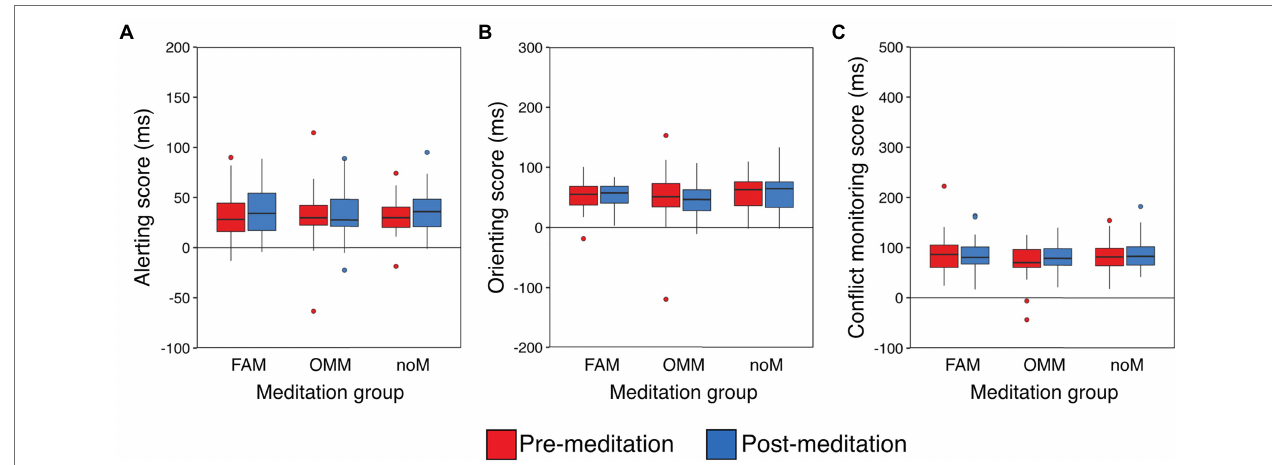
FIGURE 2 | Attentional function scores in pre- and post-meditation ANTs for the three meditation groups after excluding outliers (the scores were more than three standard deviations from the group mean), FAM: focused attention meditation, OMM: open monitoring meditation, noM: no meditation. (A) Alerting scores (FAM: n = 32, OMM: n = 30, noM: n = 32). (B) Orienting scores (FAM: n = 32, OMM: n = 31, noM: n = 31). (C) Conflict monitoring scores (FAM: n = 31, OMM: n = 31, noM: n = 31). Red and blue boxes and circles show the results of the pre- and post-meditation ANT, respectively. In each box-and-whisker plot, the central horizontal line indicates the median, and the bottom and top edges indicate the first and third quartiles, respectively. The upper whisker extends from the edge to the largest value within 1.5 times the interquartile range (IQR) from the edge. The lower whisker extends from the edge to the smallest value within 1.5 times the IQR of the edge. Data points beyond the ends of the whiskers are plotted